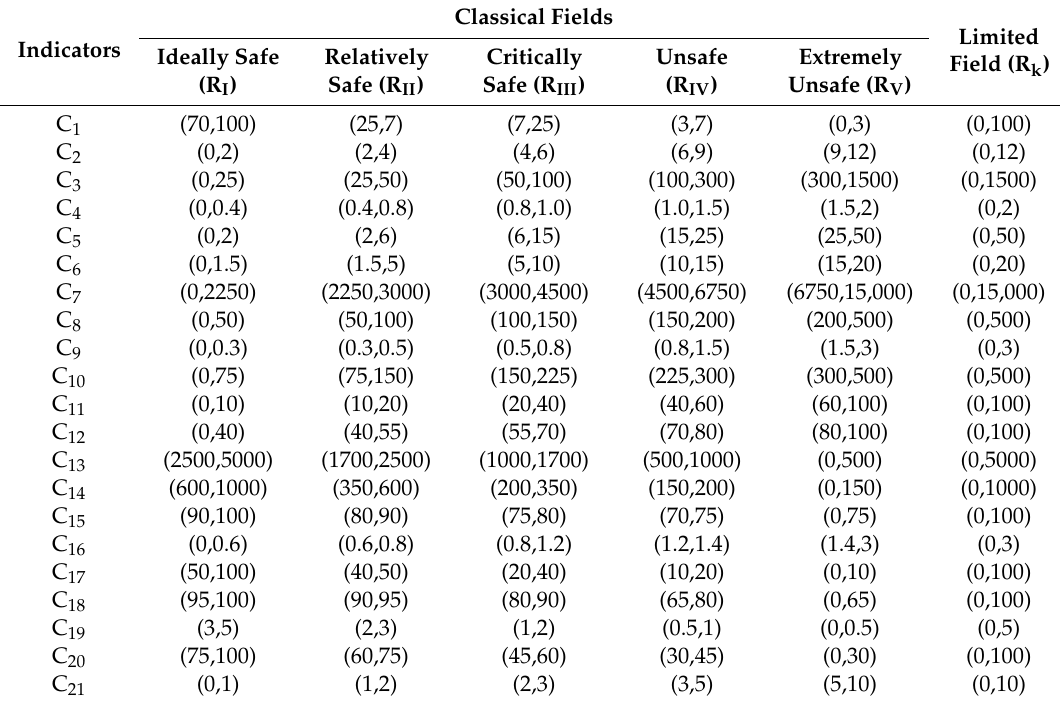
Table 4. Classification of the WRCC ranks, classic domain, and limited domain.